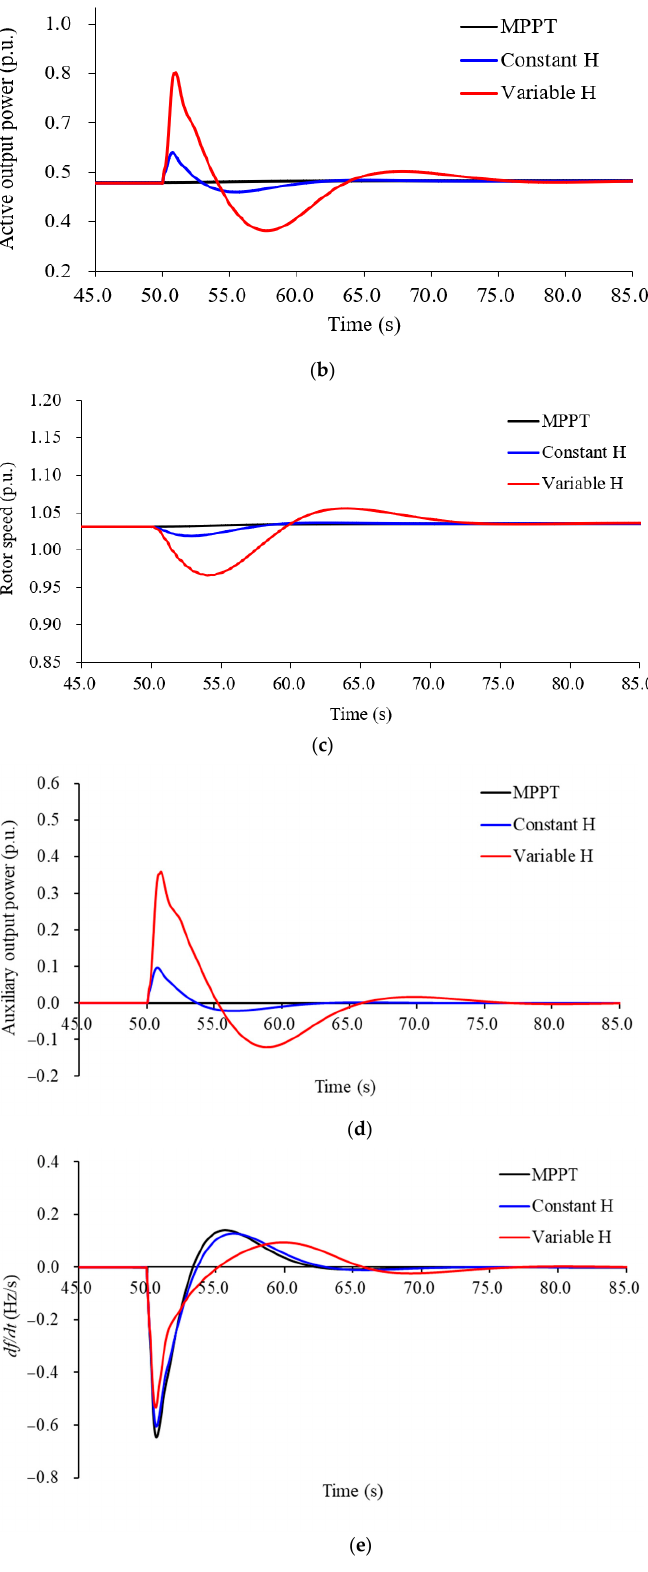
Figure 8. Results for Case 2: ( a ) system frequency; ( b ) output power; ( c ) rotor speed; ( d ) auxiliary active power; ( e ) rate of change of frequency.